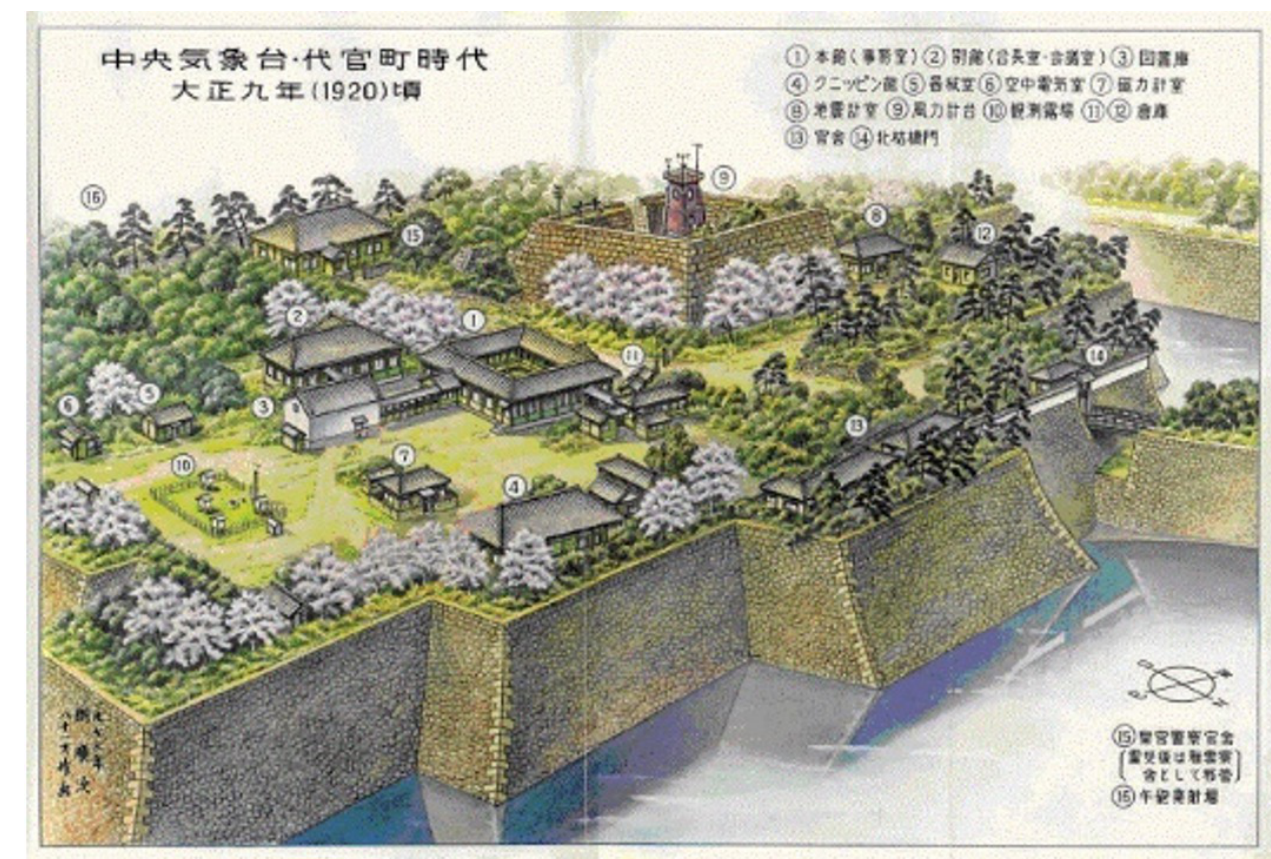
Figure 2. Central Meteorological Observatory at Honmaru of Edo Castle. The building numbered 7 is for geomagnetic observation, and 6 is for atmospheric electric field observation (map supplied by the Japan Meteorological Agency).